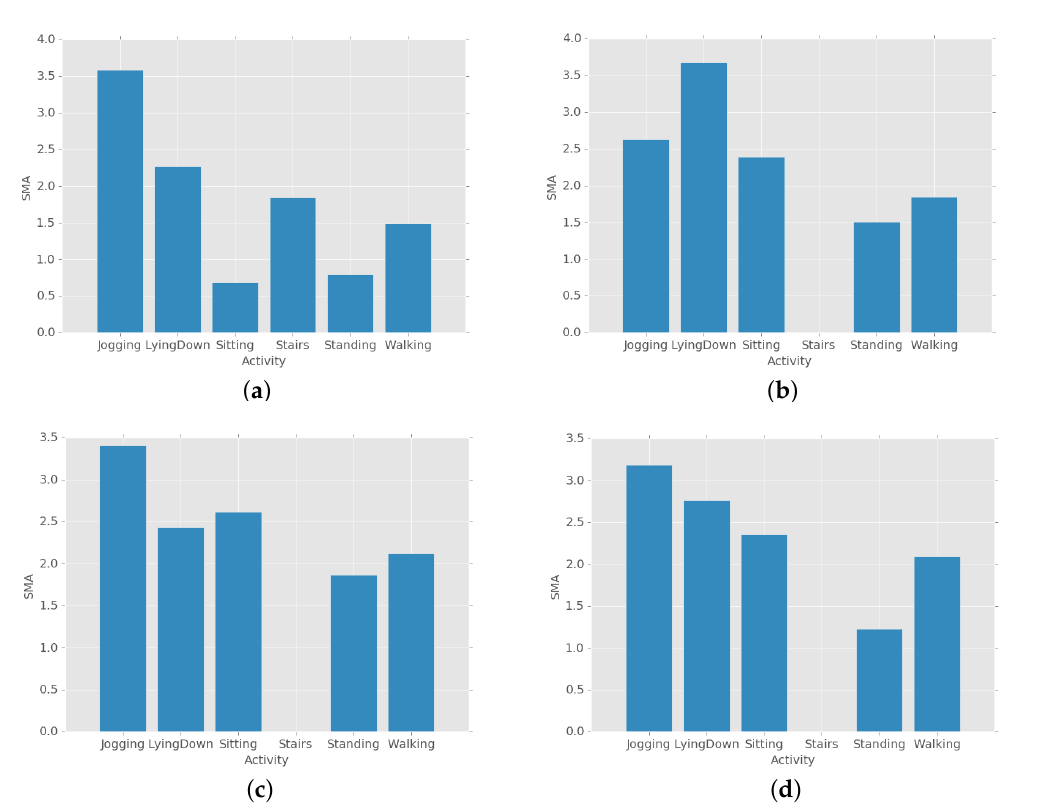
Figure 3. Examples of the average SMA values of the activities of four subjects ( a ) subject id 194 ( b ) subject id 650 ( c ) subject id 565 ( d ) subject id